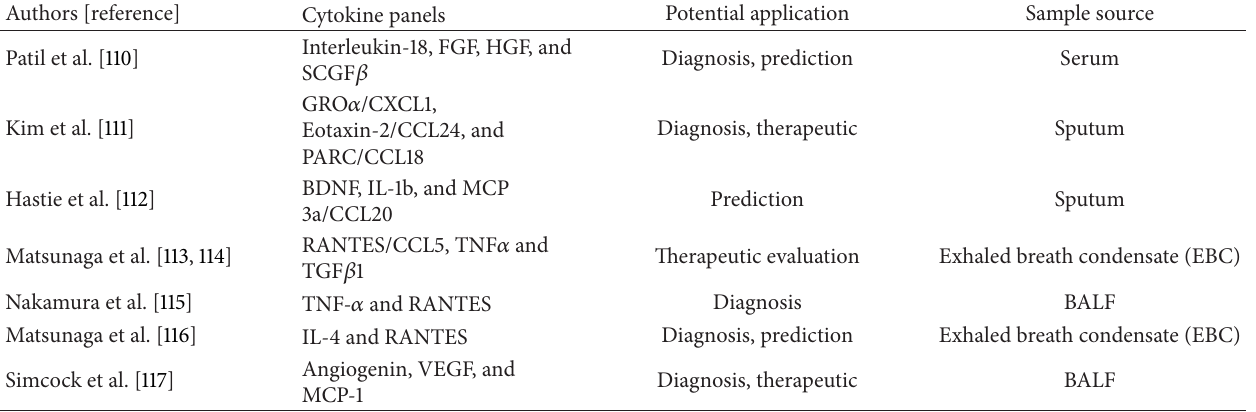
Table 2: Cytokine biomarkers in asthma explored by using antibody array